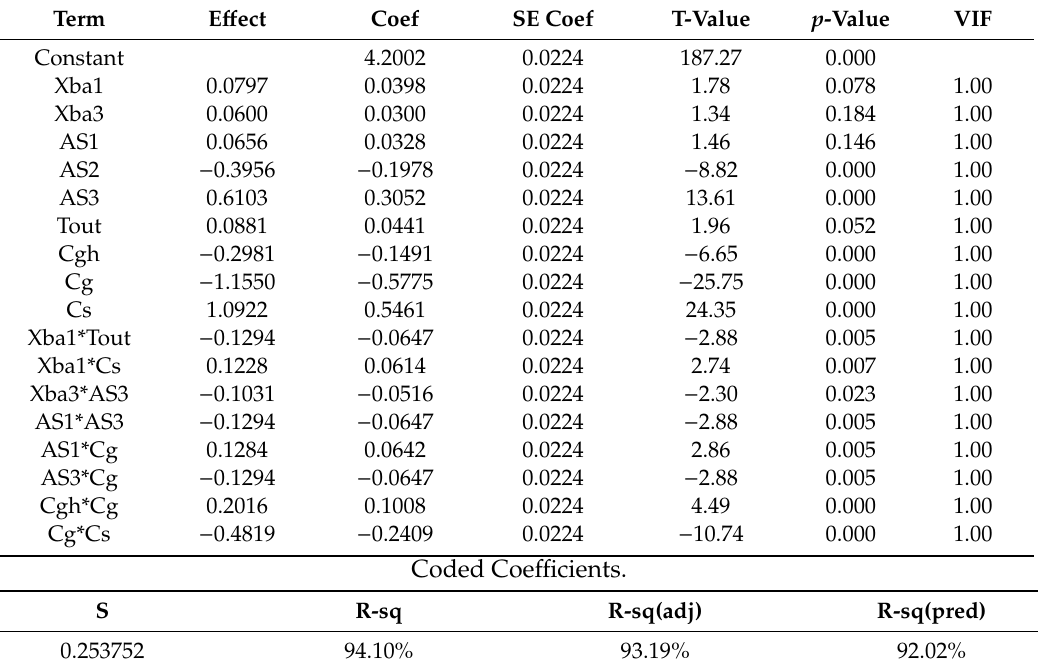
Table 5. Estimated e ff ects and coe ffi cients for u 3